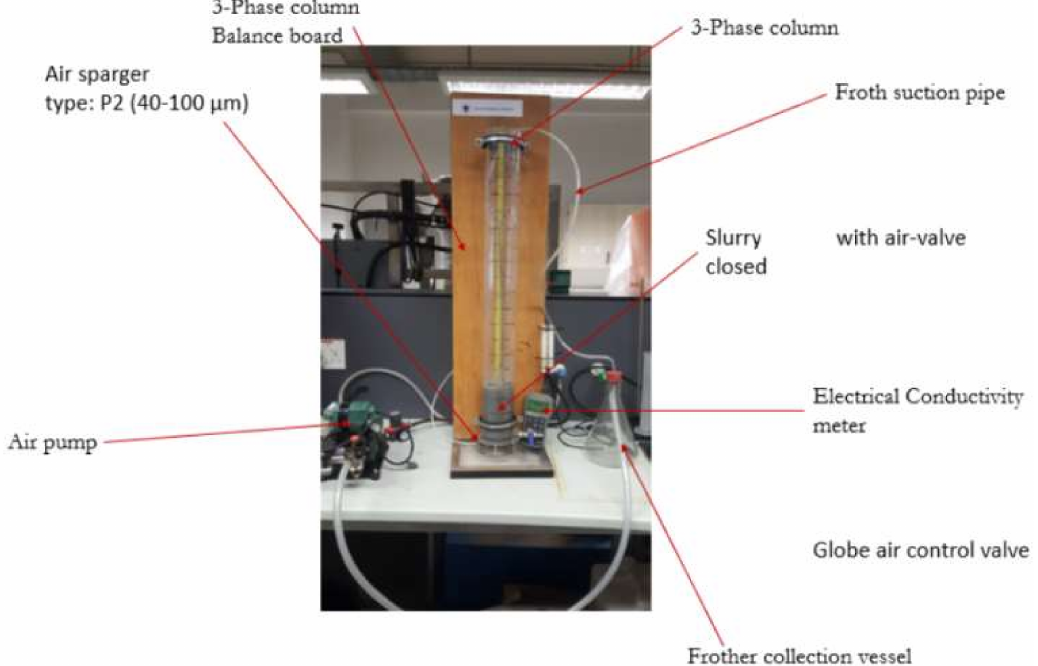
Figure 1. Three-phase froth column set